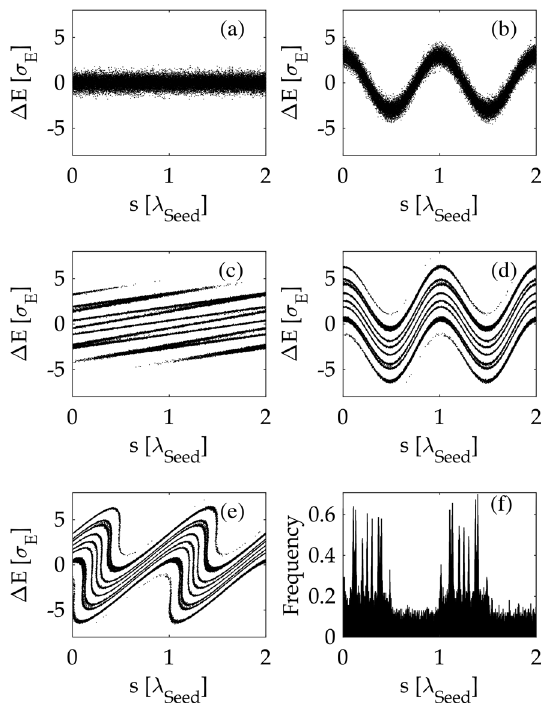
FIG. 6. Evolution of the longitudinal phase space distributions during the EEHG process. The horizontal axis is the bunch coordinate s in units of seeding wavelength λ , while the Seed vertical axis shows the deviation from the central energy Δ E in units of the uncorrelated energy spread σ . Shown is the energy E spread at 5 locations a , b , c , d and e as indicated in Fig. 5 and a histogram of the electron density at location e in (f). One can see that a larger fraction of the electrons is confined within distances much smaller than the seed wavelength, thus having a much higher harmonic content than in Fig. 2(d).